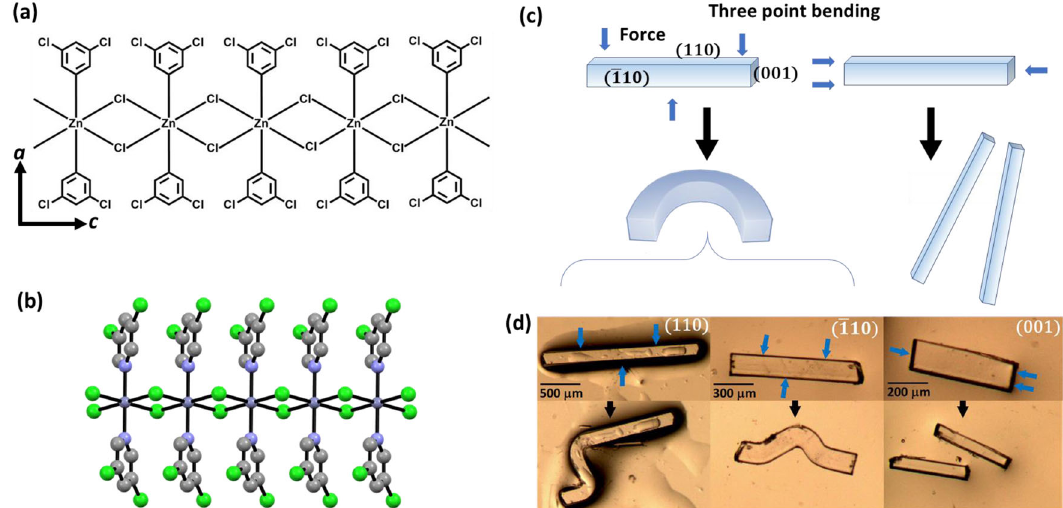
Fig. 1 Description of [Zn( μ -Cl) 2 (3,5-dichloropyridine) 2 ] n (1), as reported in our previous work 9 . a Schematic representation of the coordination polymer chains of ( 1 ). b Ball and stick model representation of the coordination polymer chain shown in a . Atoms are coloured as C- grey; N- blue; Cl- green; Zn – dark blue. c Schematic representation of three-point bending. Crystal bending is achieved by immobilising the ends of the crystal on one face and exerting a force in the opposing direction. Blue arrows show the direction of three-point bending. d Microphotographs of plastically bent crystals along with the (110) and ( (cid:1) 110) faces, and brittle along the CP chains, i.e., the (001) face. Blue arrows show the direction of three-point bending as in c